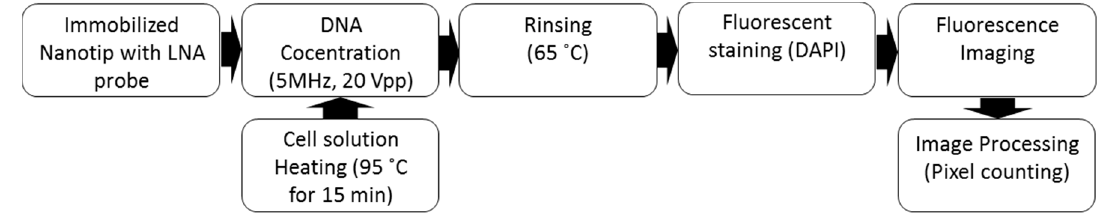
Figure 9. Experimental procedure for DNA concentration and detection using a dendritic nanotip.